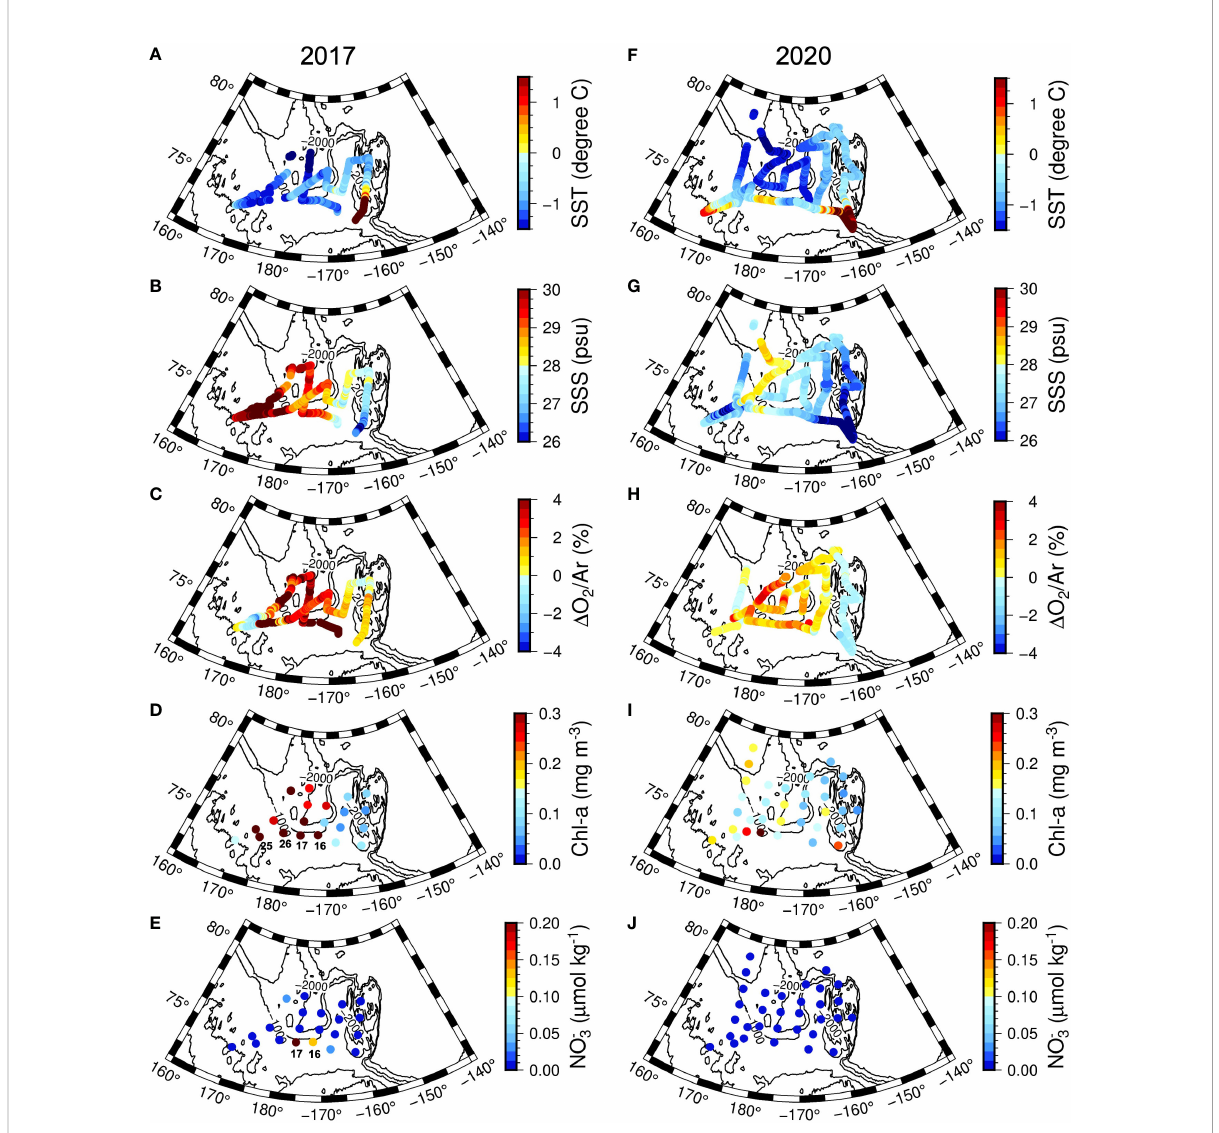
FIGURE 3 Horizontal distributions of SST, SSS, D O 2 /Ar, Chl- a , and nitrate (NO 3- ) in (A – E) 2017 and (F – J) 2020. The Chl- a and nitrate concentrations are averages of mixed layer for each